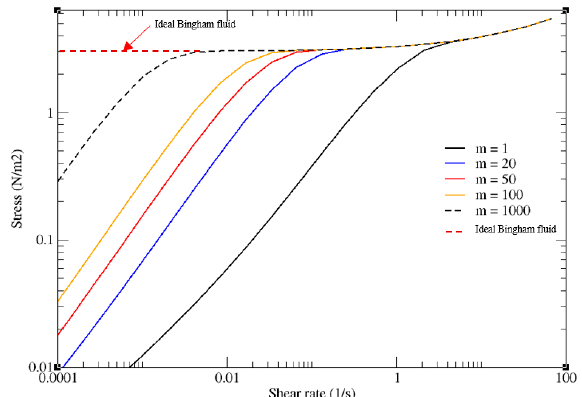
Figure 1. Shear stress versus shear rate for di ff erent values of m according to the Papanastasiou Bingham model.